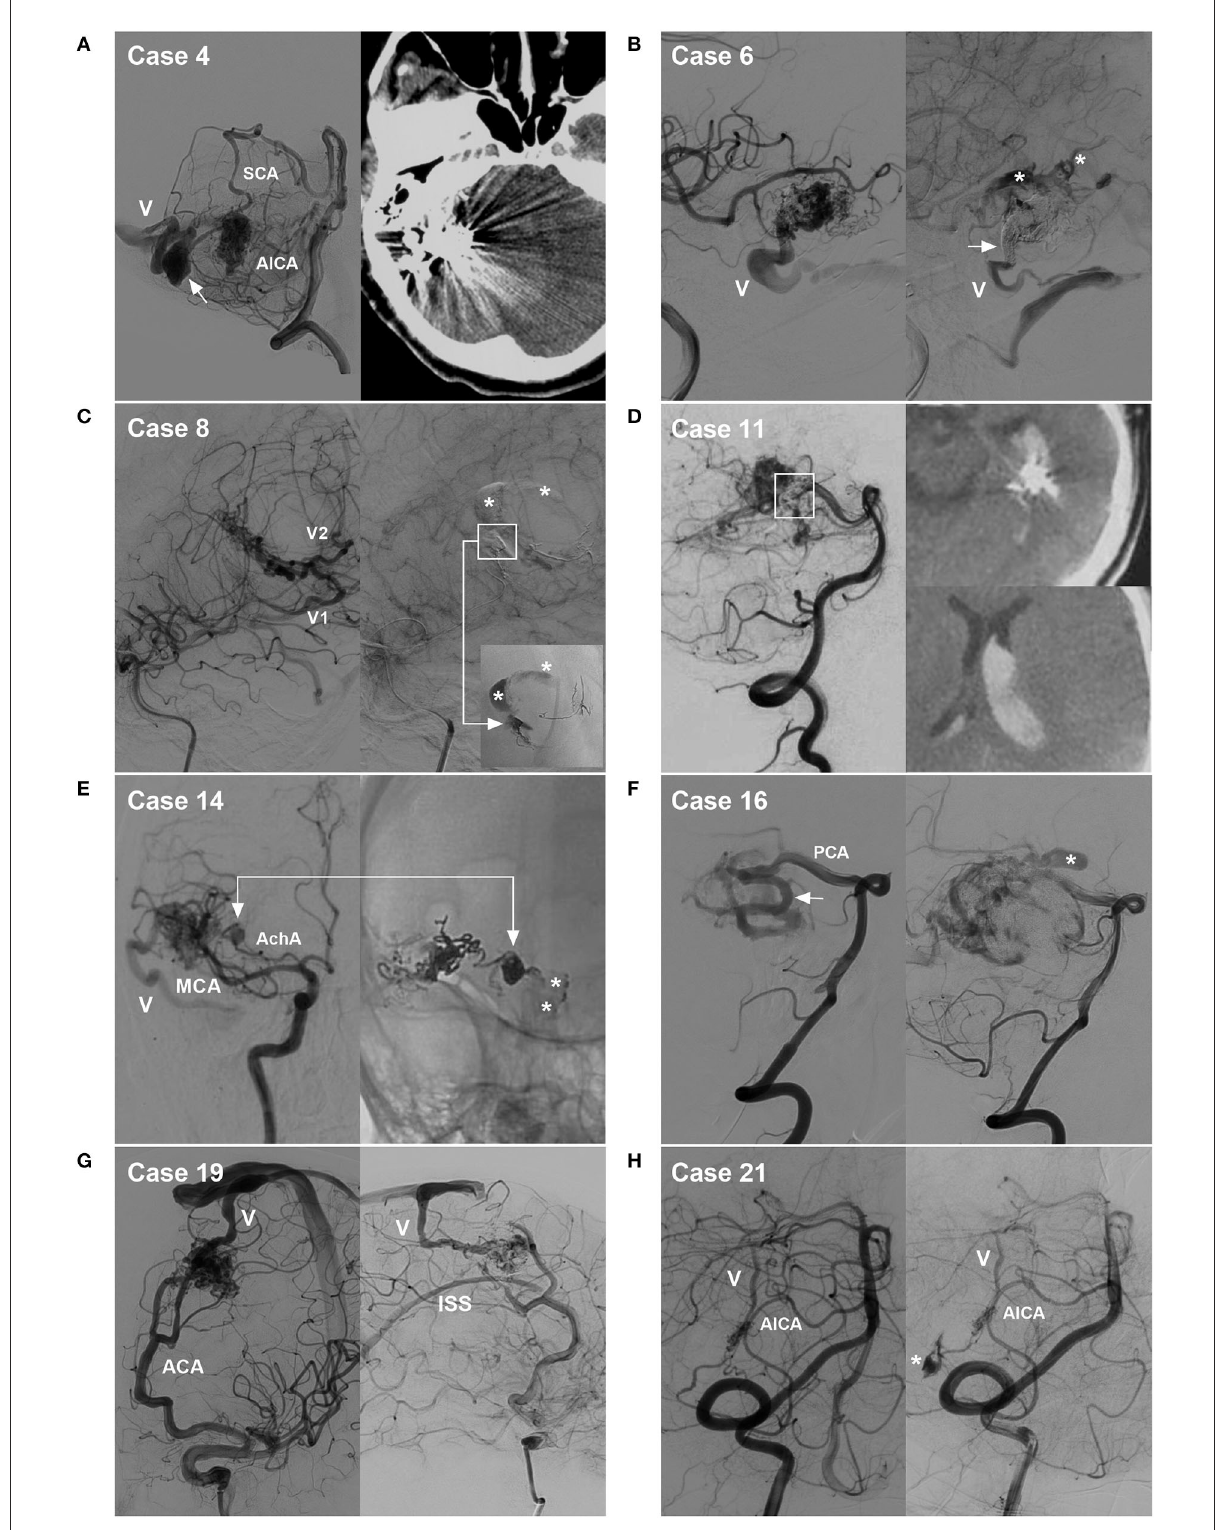
FIGURE8 Cases of hemorrhagic complications. (A) Draining vein system rupture: left, pre-operative angiogram showing the BAVM supplied by the SCA and AICA, with the draining vein (V) and a large venous aneurysm (arrow); right, post-operative CT showing venous edema and